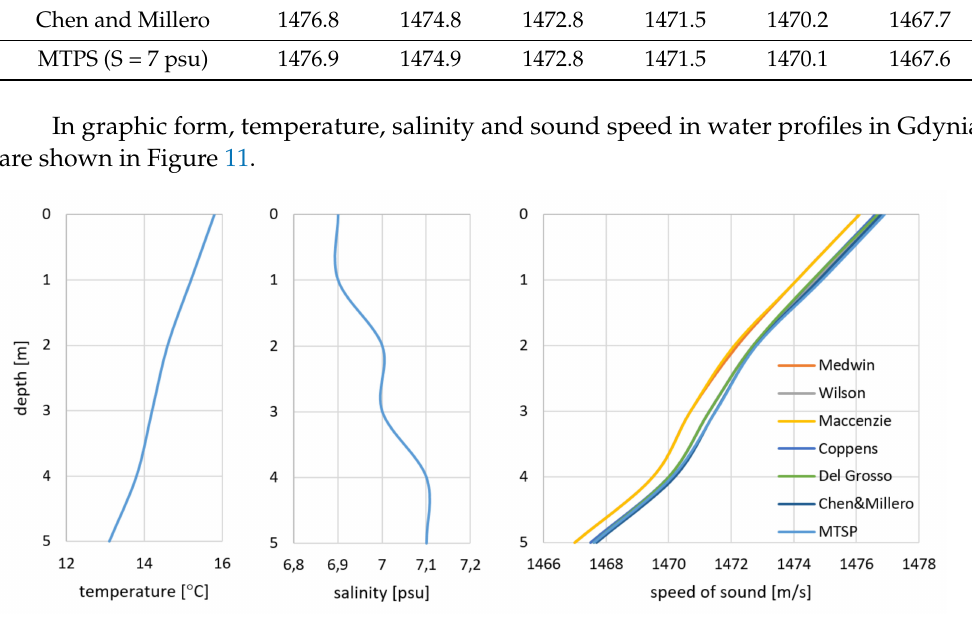
Figure 11. Temperature, salinity and sound speed in water profiles in Gdynia. The depth errors for measurements in a public beach in Gdynia in the range of 0–5 m are presented in Table 10. For constant salinity S = 7 psu, the difference between the depth determined using vertical distribution of the sound speed and on the basis of the simplified method is not more than 3 cm. Table 10. Depth measurement error (cm) for selected formulas according to MTPS (S = 7 psu) in Gdynia.